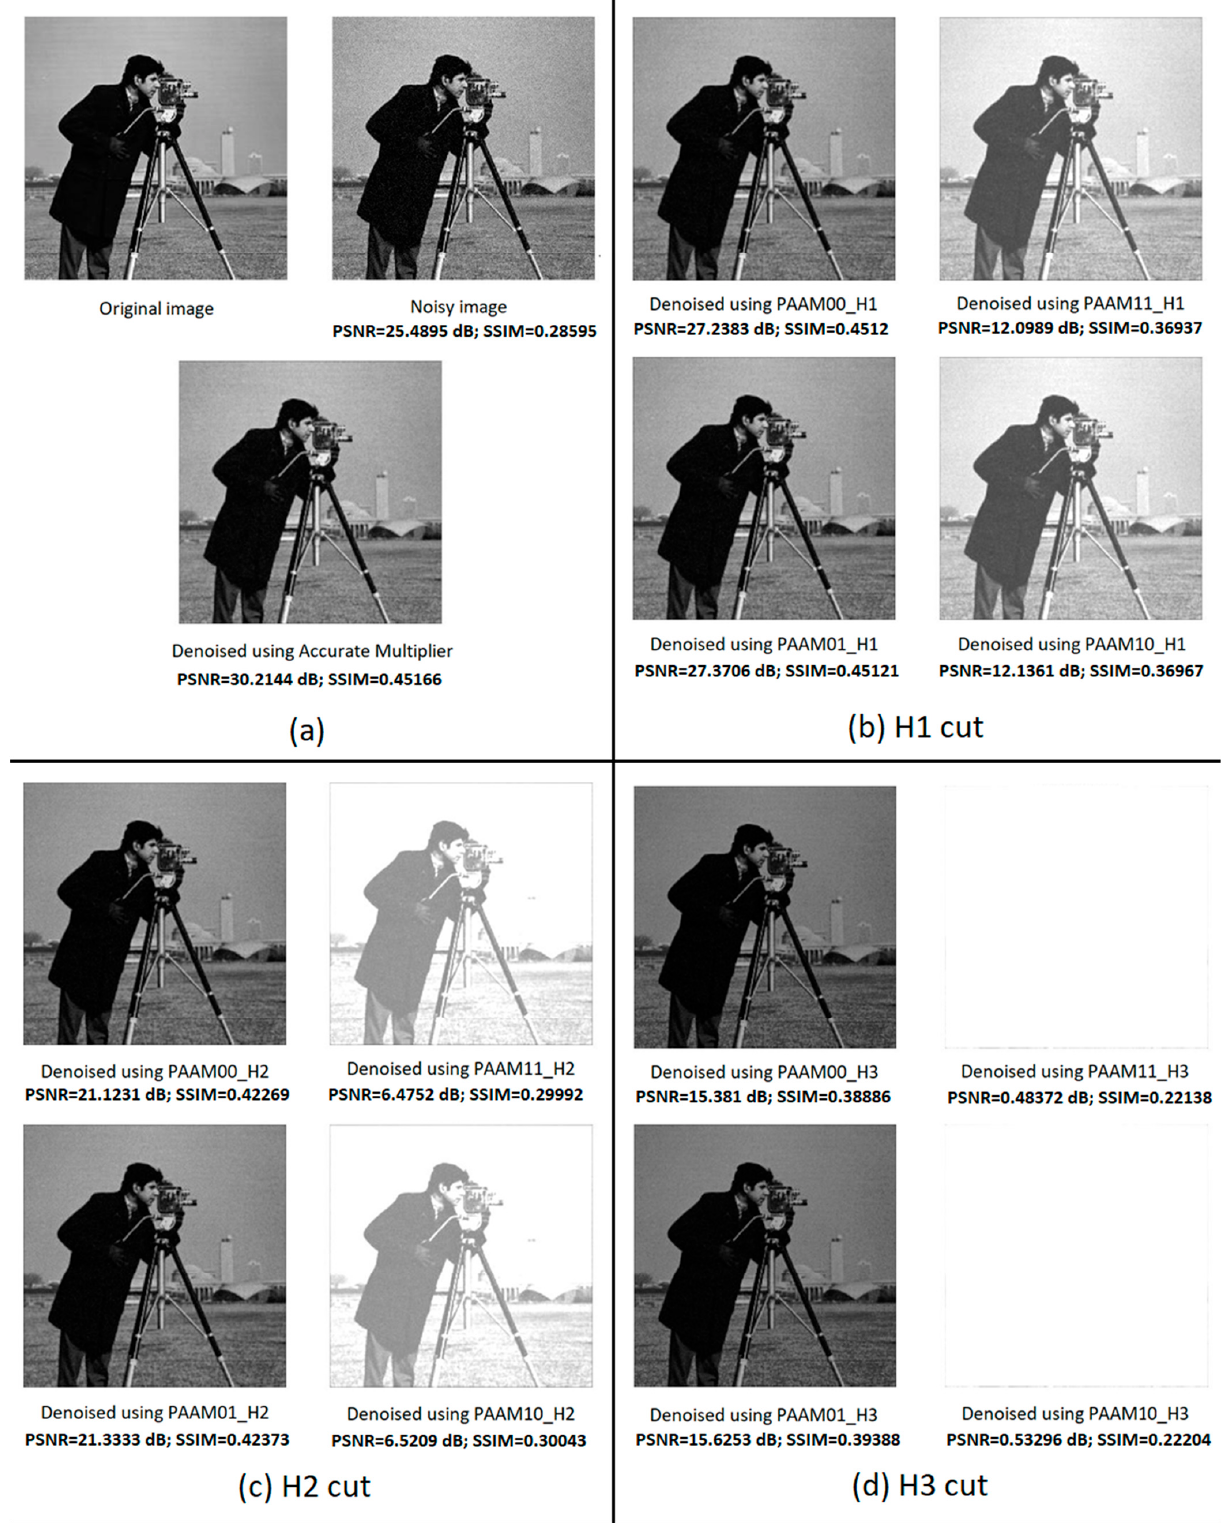
Figure 8. Denoised images obtained using approximate array multipliers resulting from: ( a ) V5 cut; ( b ) V6 cut; ( c ) V7 cut; ( d ) V8 cut; and ( e ) V9 cut.